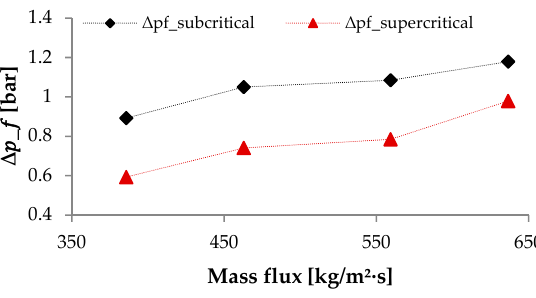
Figure 6. Frictional pressure drop ∆ p f for various mass fluxes at subcritical and supercritical conditions. ∆ p f : frictional pressure drop.